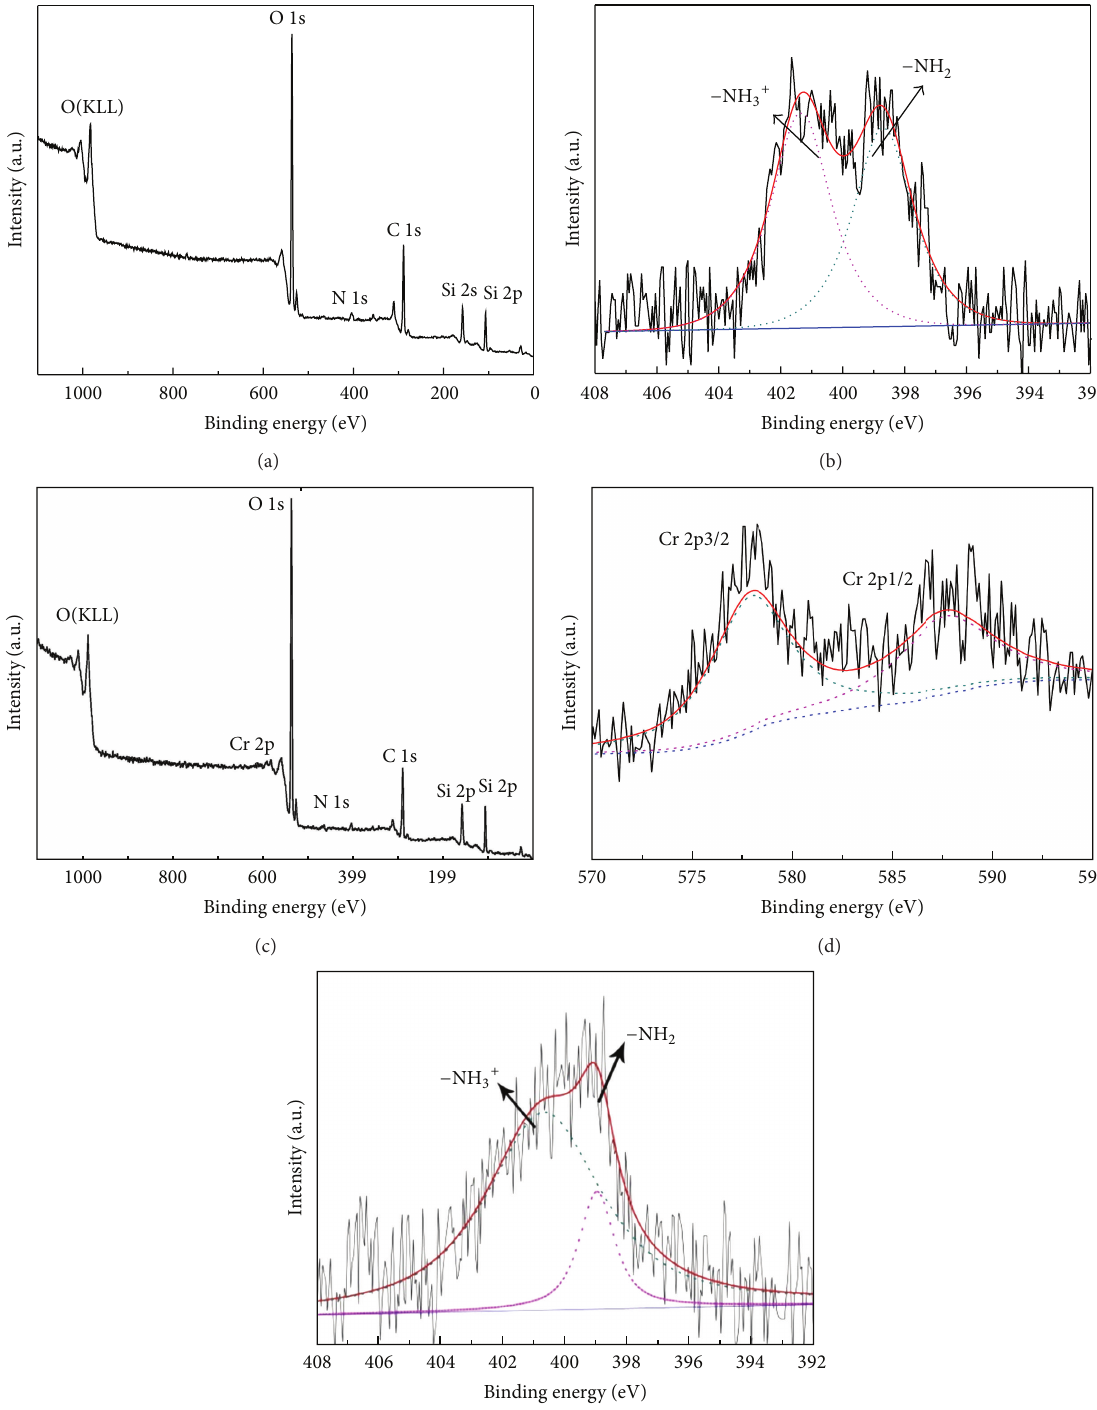
Figure 3: XPS spectra of NH 2 -MCM-41 and Cr–NH 2 -MCM-41. (a) Over all spectra of NH 2 -MCM-41; (b) N 1s spectra of NH 2 -MCM-41 before adsorption; (c) overall spectra of Cr–NH 2 -MCM-41; (d) Cr 2p spectra of Cr–NH 2 -MCM-41; (e) N 1s spectra of NH 2 -MCM-41 after